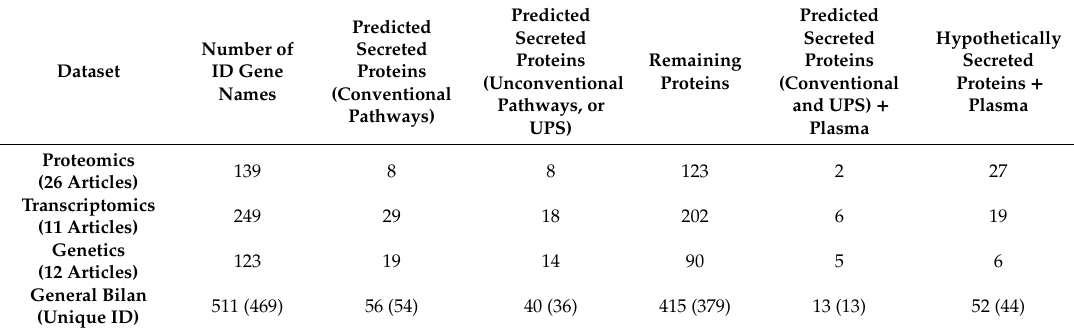
Table 1. Description of the computational analysis of the datasets included in the study.